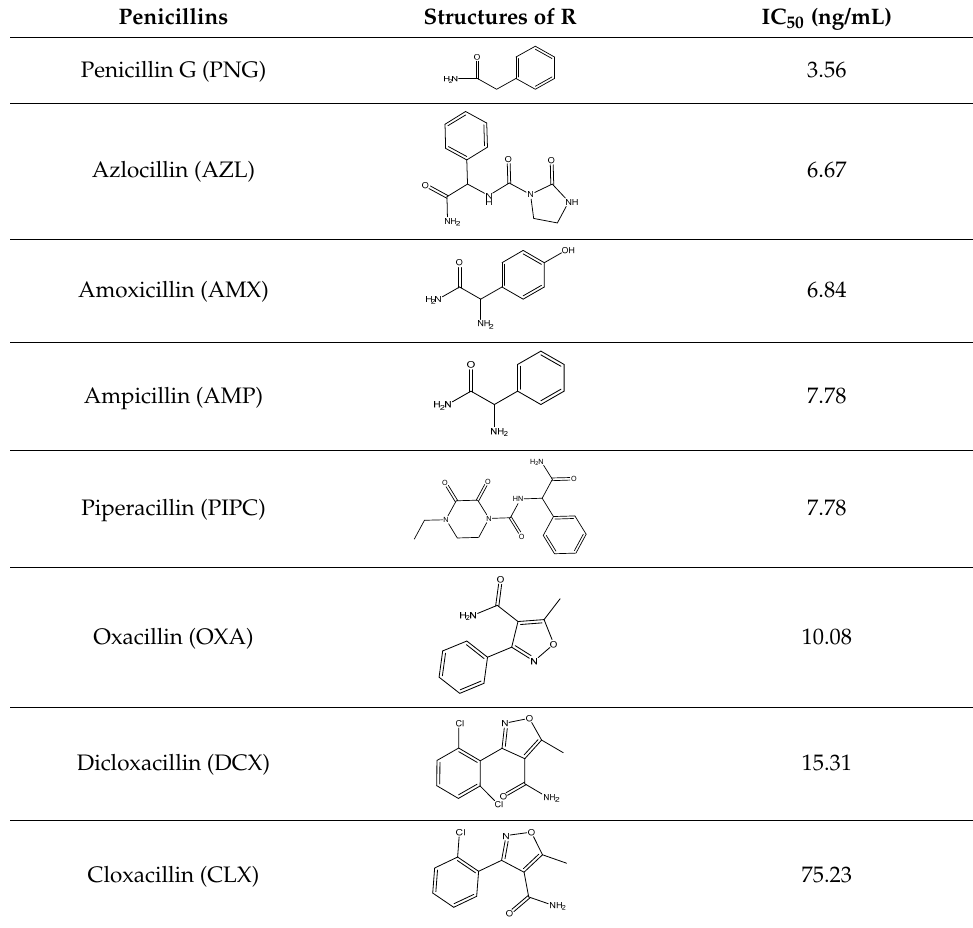
Table 1. The affinity of penicillins to PBP2x*.